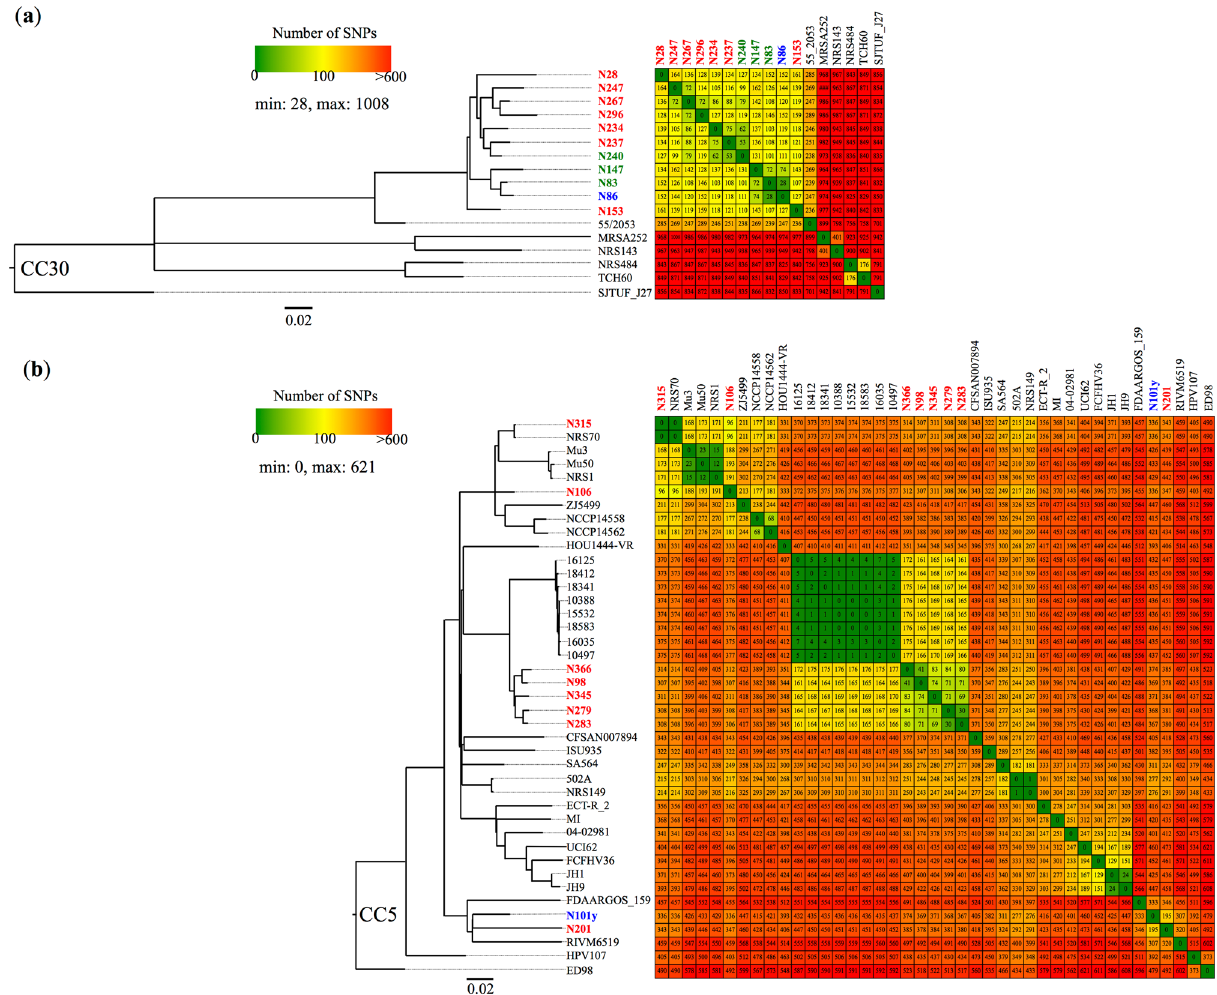
Figure 2. The phylogenetic inter-strain relationships within the same clonal complex based on pairwise SNP differences. ( a ) Phylogenetic tree based on whole-genome SNPs in CC30 strains. Staphylococcus aureus strain SJTUF_J27 was used as the outgroup. NJ tree was constructed based on the alignment of 2353 SNP sites. ( b ) Phylogenetic tree based on whole-genome SNPs in CC5 strains. S . aureus strain ED98 was used as the outgroup. NJ tree was constructed based on the alignment of 3684 SNP sites. mecA -positive MRSA, mecA -negative MRSA, mecA -positive MSSA isolated in this study and reference strains were indicated in red, blue, green and black letters, respectively. The numbers of inter-strain SNP differences were visualized in a red-yellow-green gradient with red indicating the top score (> 600) and green indicating the bottom score (0). CC clonal complex, MRSA methicillin-resistant Staphylococcus aureus , MSSA methicillin-susceptible Staphylococcus aureus , NJ neighbor- joining, SNPs single nucleotide